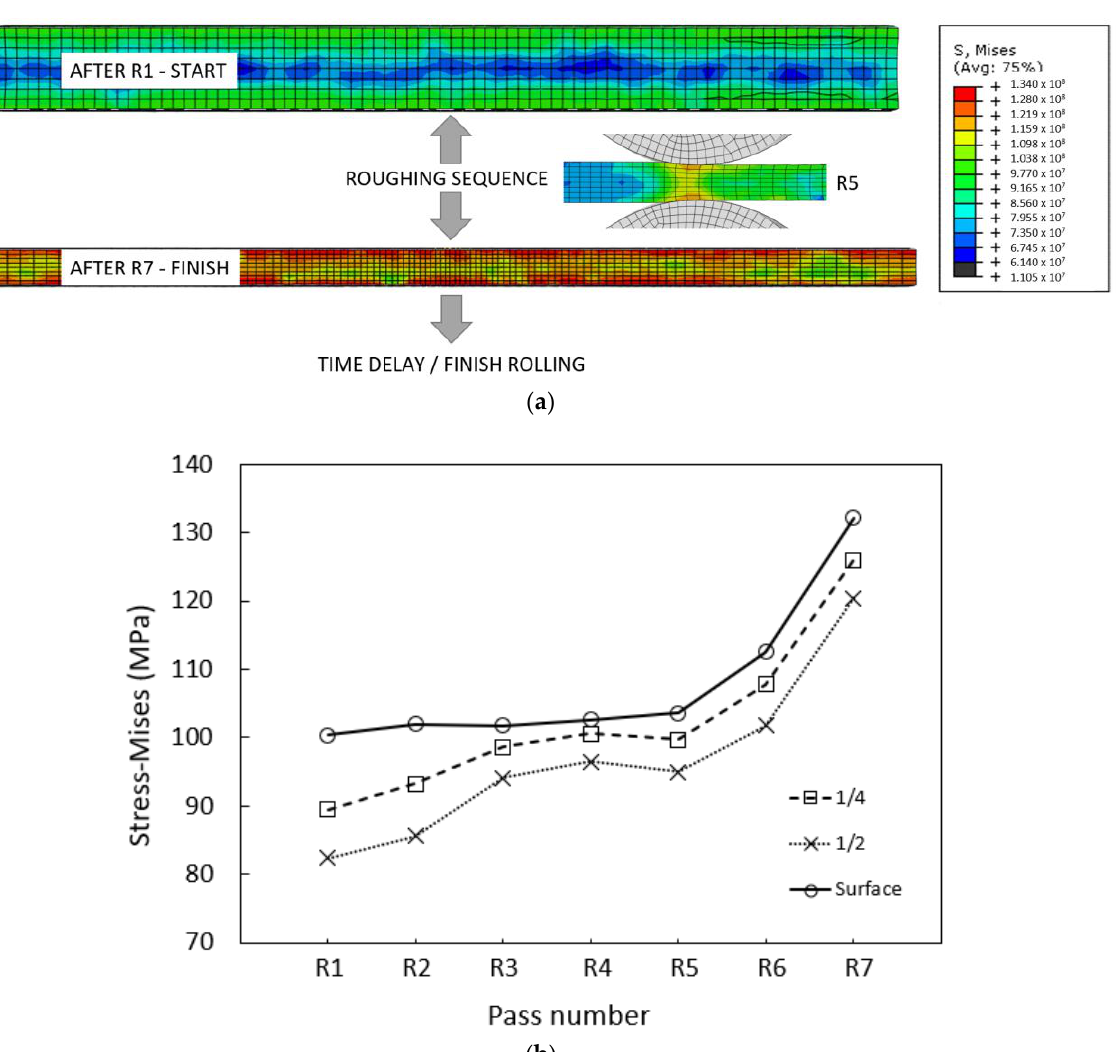
Figure 4. ( a ) FEM simulated effect of rolling schedule on through-thickness non-homogeneous stress distribution (from surface to center). The cross-section is taken mid-length of the plate. ( b ) Stress variation determined at the highest stress levels inside the effective rolling region shows an obvious change in the cross-section deformation efficiency and related dislocation density due to not only the change in temperature-dependent material characteristics but also the change in work roll-speed rotation as in the case of R6 and R7 (with comparable per-pass strain).